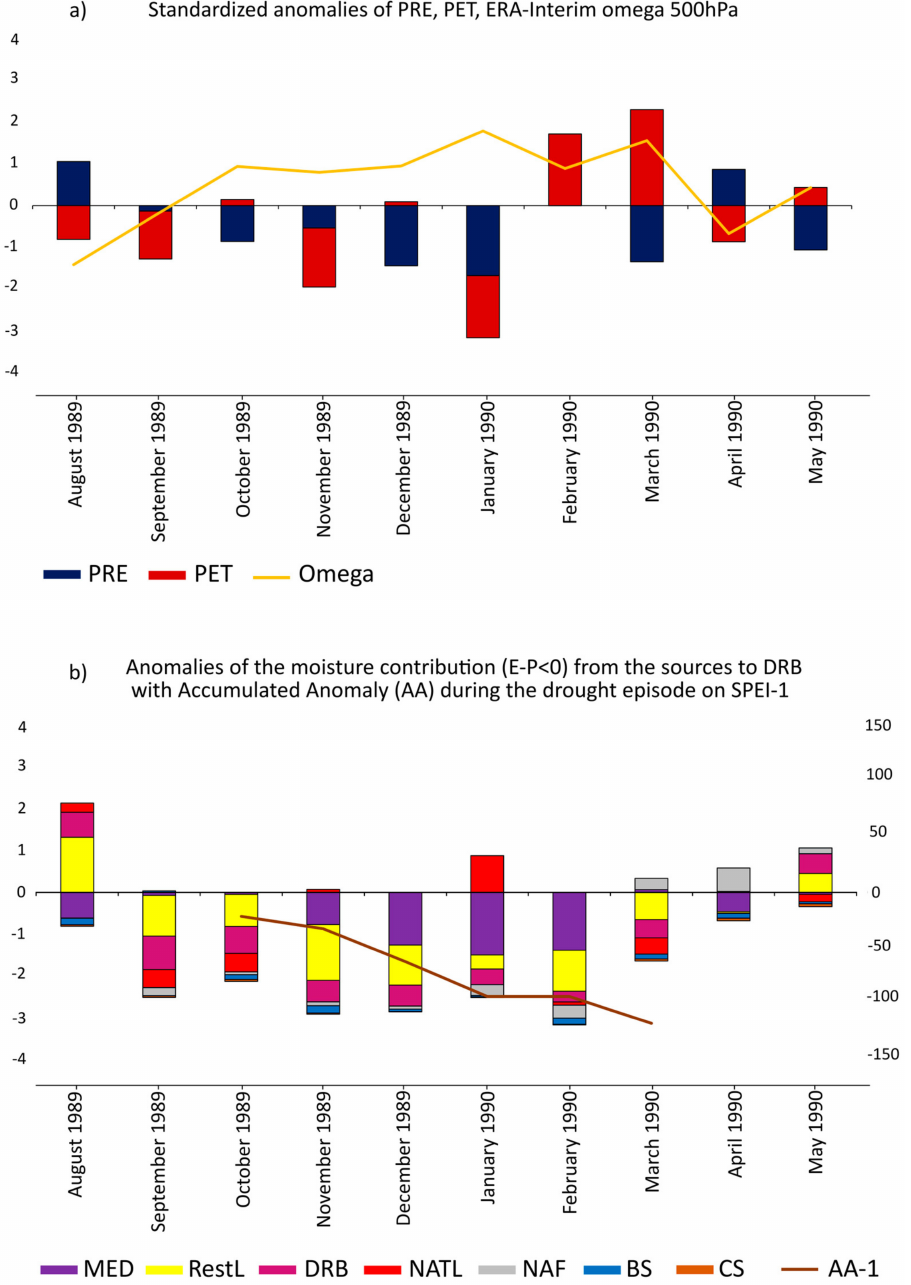
Figure 4. ( a ) Standardized anomalies of the precipitation (PRE, blue bars), potential evapotranspiration (PET, red bars) (data from Climatic Research Unit (CRU) Time Series (TS) 3.23), and ECMWF Re-Analysis (ERA)-Interim omega at 500 hPa (omega 500, yellow line), and ( b ) Anomalies in the moisture supply (E – P < 0) (accumulated bars) by each source over the DRB obtained via the forward FLEXPART experiment (left axis, in mm/day) and the accumulated precipitation anomalies (brown line AA-1) (right axis, in mm/month) for the 1989–1990